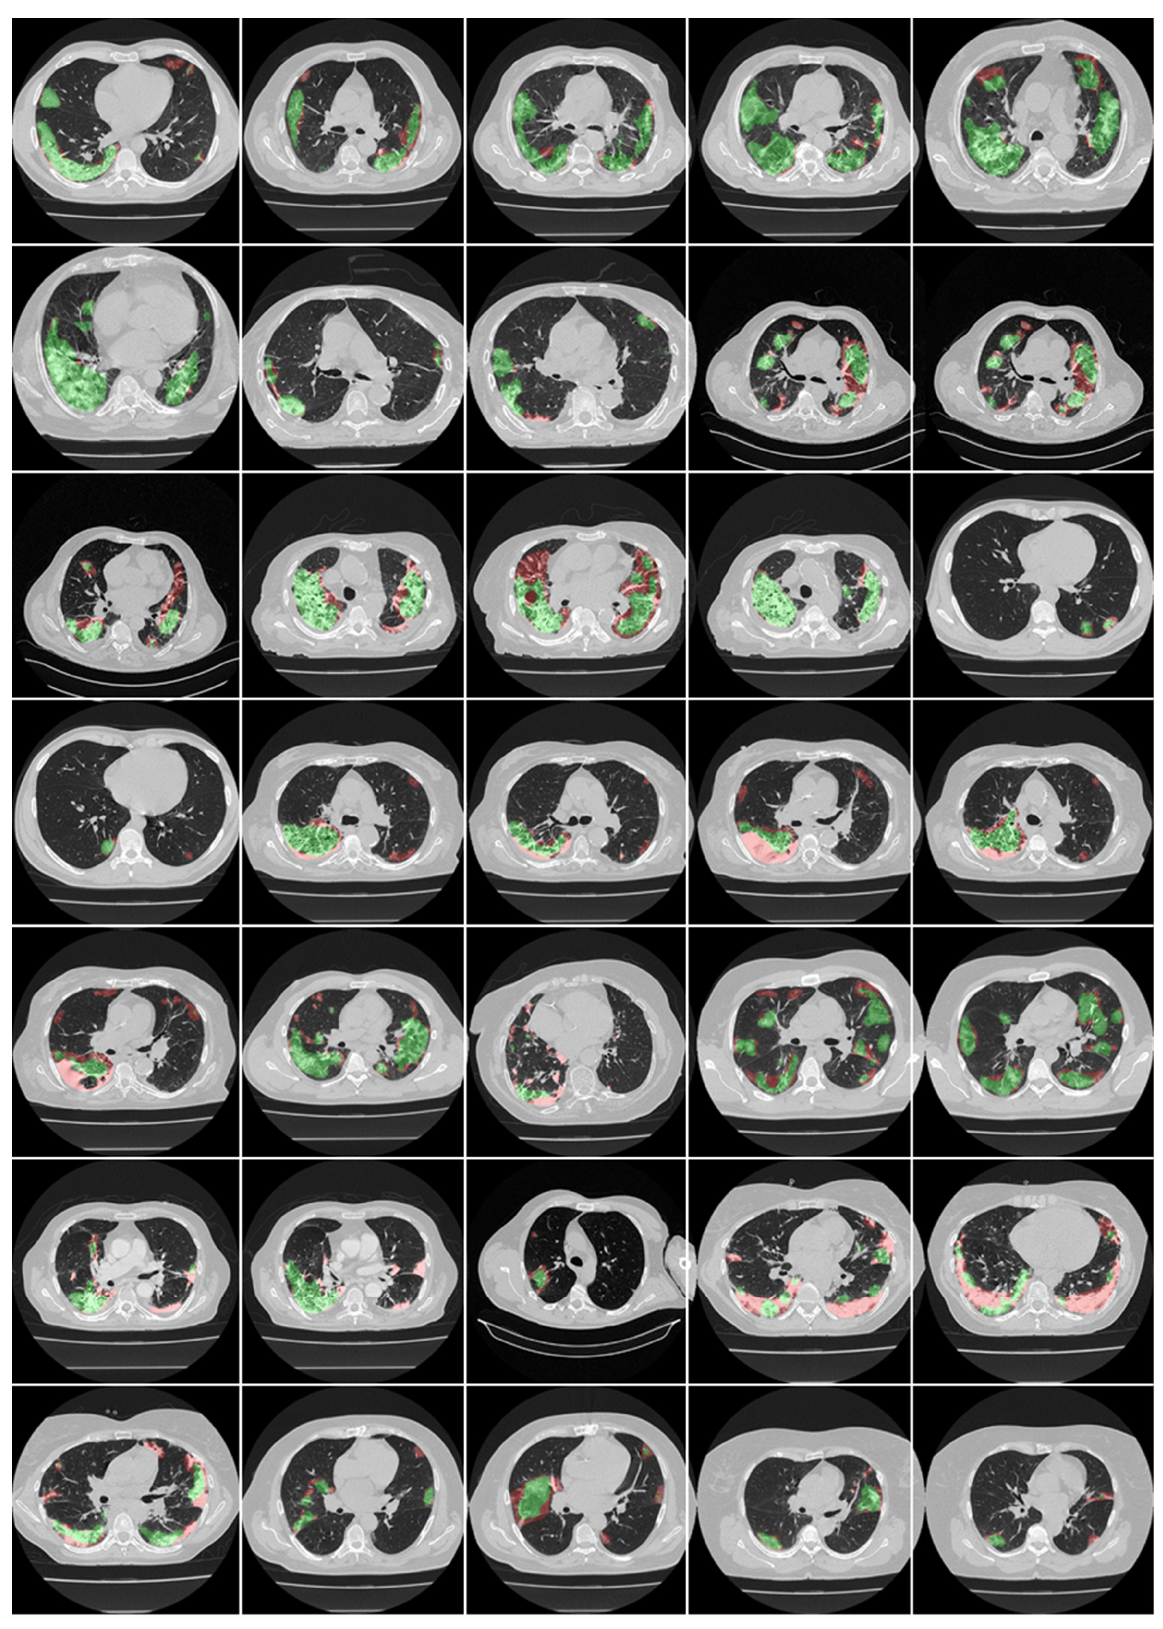
Figure A2. Results of visual lesion overlays showing VGG ‐ SegNet (green) vs. MD 1 (red).